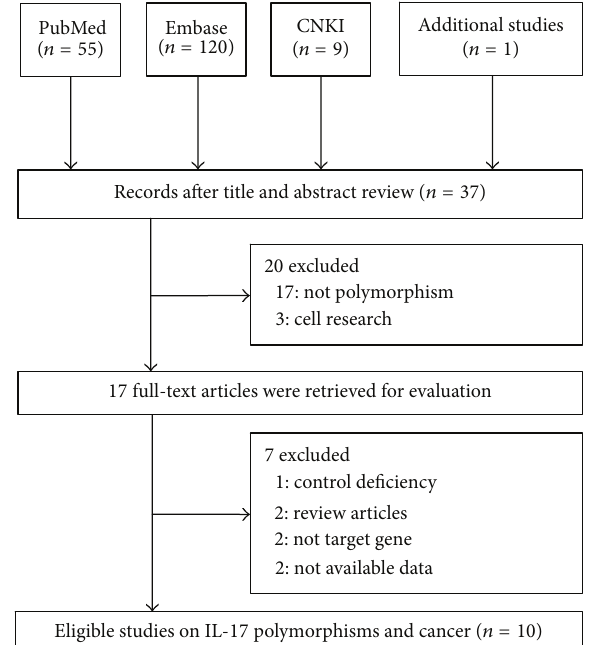
Figure 1: Flow chart of study